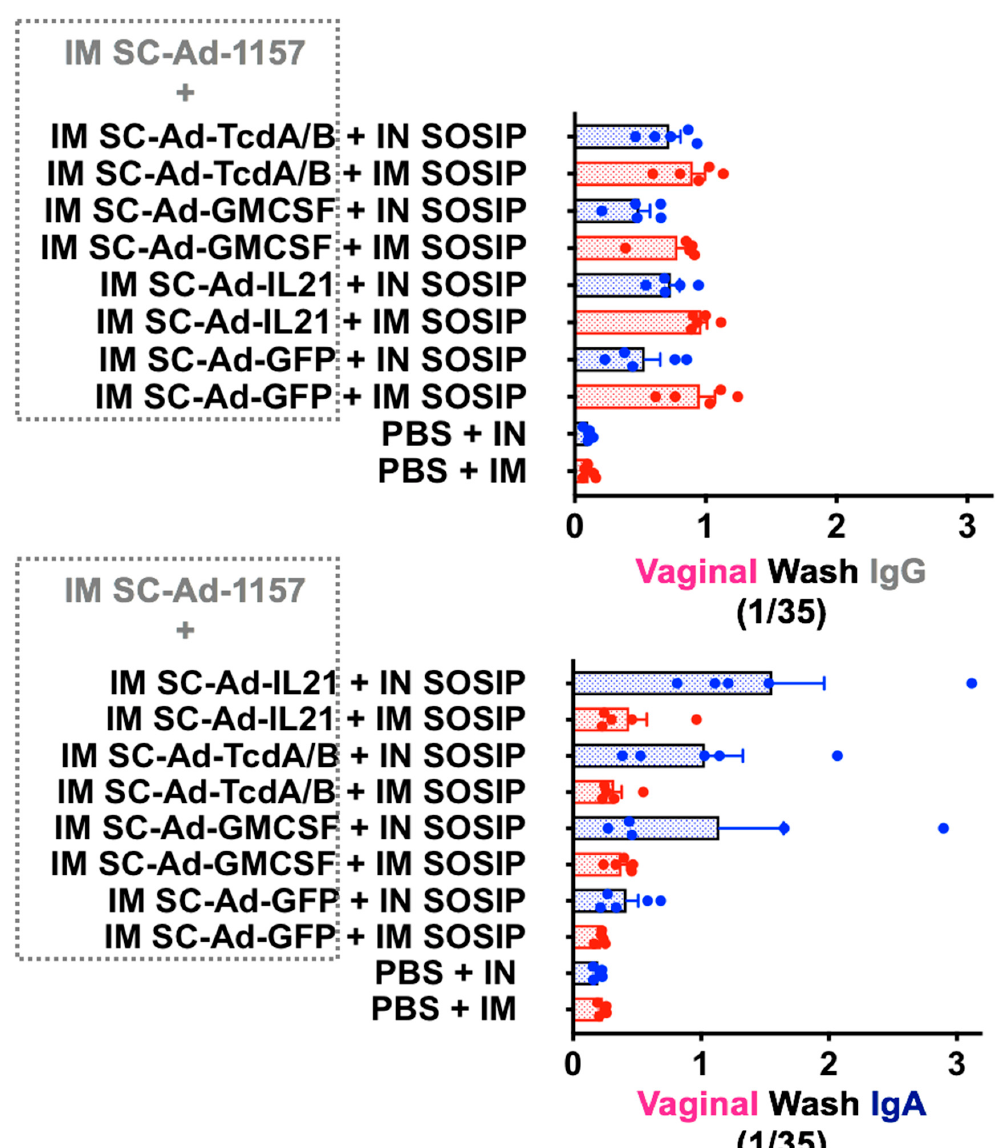
Figure 4. IM or IN SOSIP protein boost of SC-Ad-env + SC-Ad-genetic adjuvants. The groups of 10 mice from Figure 3 were divided and boosted with 5 µ g CZA clade C SOSIP protein adjuvanted with 1 µ g alphaGalCer by either the IM or IN route. Two weeks later, 1 / 35 dilutions of vaginal washes were assay for anti-CN54 IgG or IgA antibodies by ELISA.